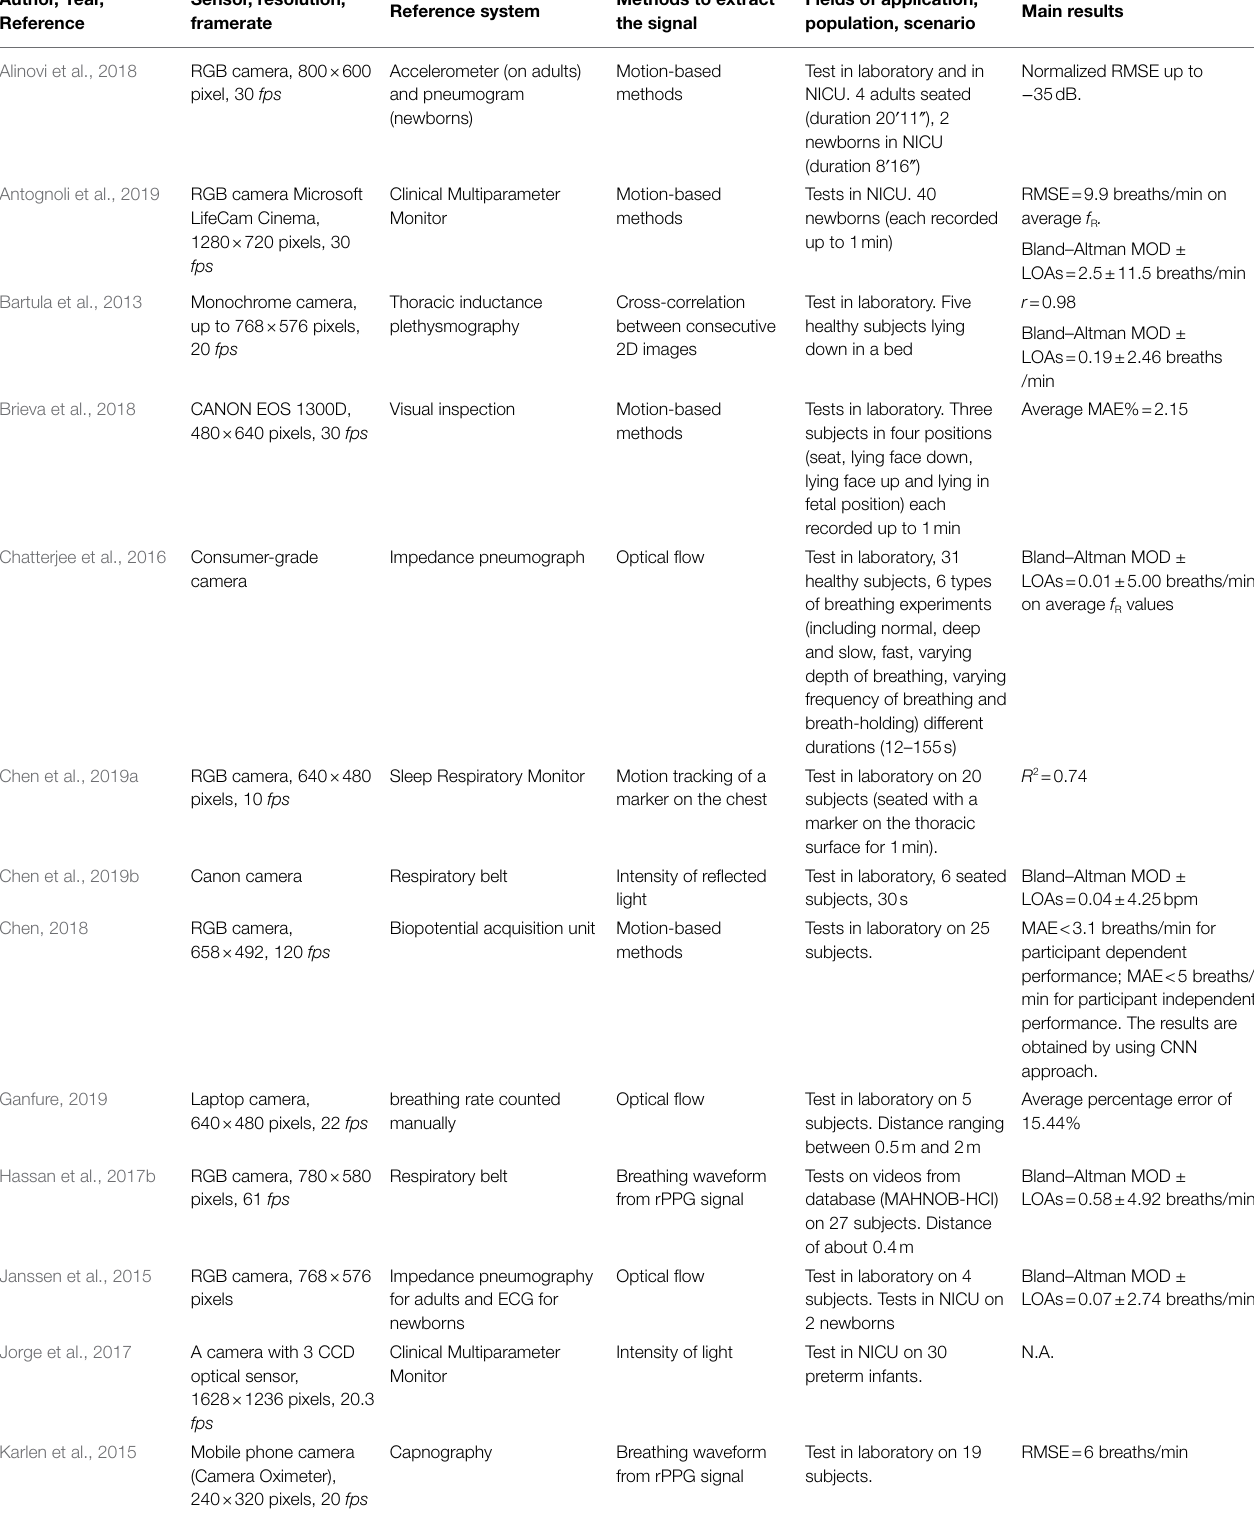
TABLE 1 | Studies using digital cameras for estimating f R and other respiratory parameters in different fields of